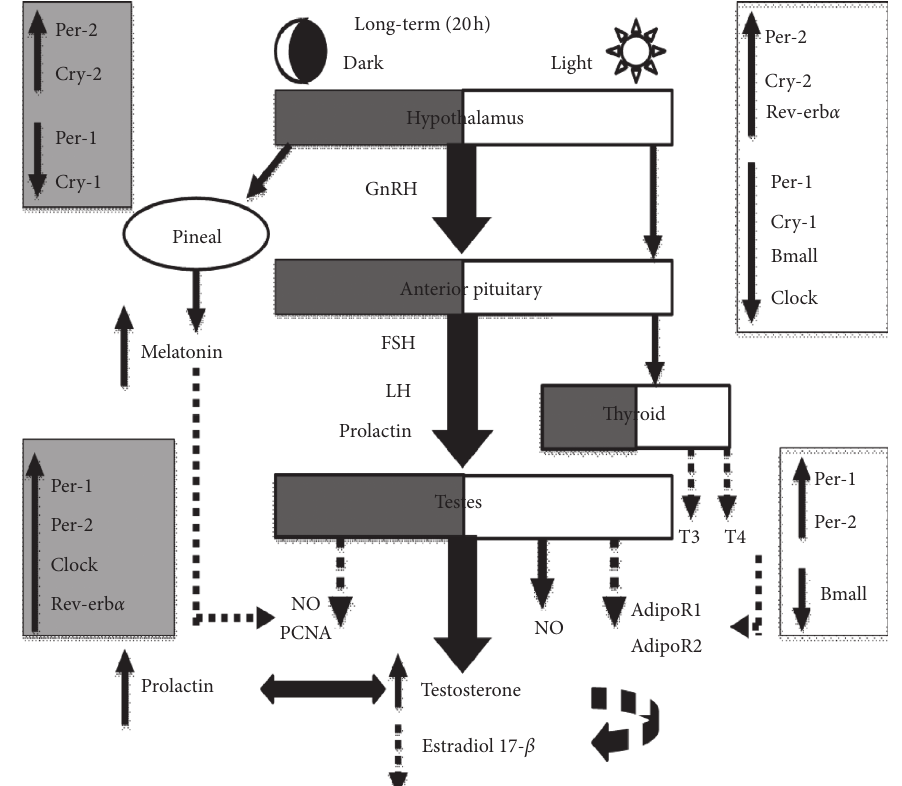
Figure 8: Schematic diagram illustrating circadian disruption-induced hormonal and genes expression changes in male rats. Solid lines indicate stimulation, while dashed lines indicate